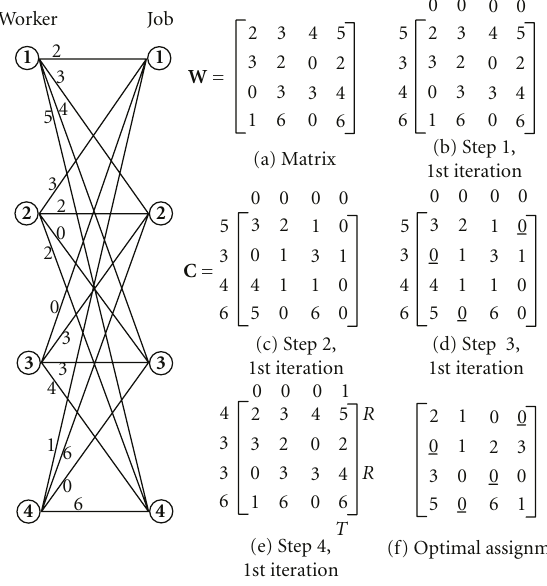
Figure 1: System model.